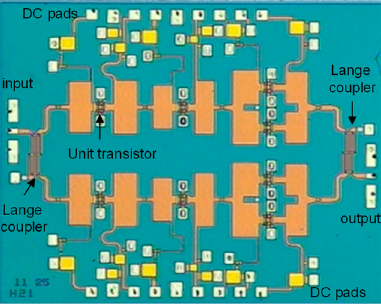
Figure 6. Fabricated W-band power amplifier IC using 60 nm GaN-on-Si HEMT foundry (chip size: 2.4 mm × 2.0 mm).